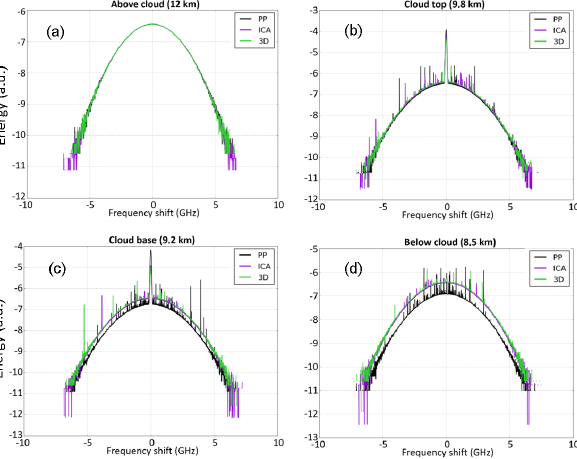
Figure 12. Normalized HSR power spectra (a) above the cloud (12km of altitude), (b) at cloud top (9.8km of altitude), (c) at cloud base (9.2km of altitude), and (d) below the cloud (at 8.5km of alti- tude). Black lines represent simulations using the PP cloud model, purple lines the ICA cloud model, and green lines the 3D box-cloud model.